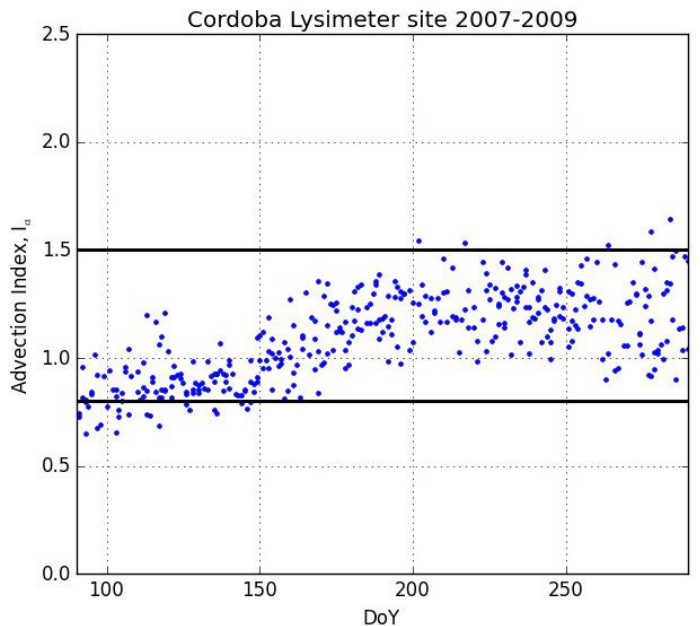
Figure 4. Advection-index being the ratio of daily means of actual L.ET and Q* , as a function of day of year (DoY). I a is estimated as the ratio between daily net radiation (obtained via Equation (2)) and daily latent heat flux obtained from observations taken over the well-watered Cordoba site (see also Figure 1 in [16]). The lower line represents the 0.8 Q* threshold beyond which LAE should be taken into account.